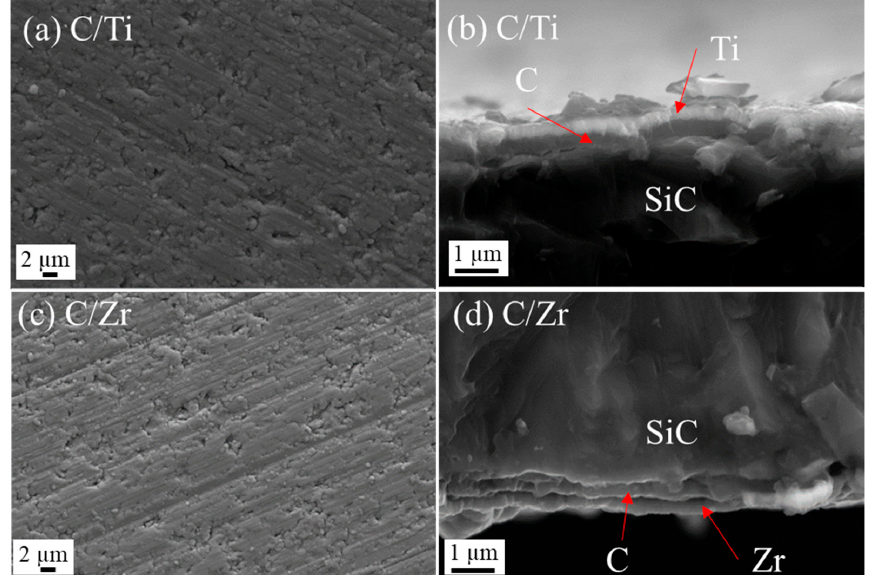
Figure 11. SEM images of surface and cross-section of sputtered coating with SE2 mode before heat treatment. ( a , b ) are the surface and cross-sectional image of sputtered C/Ti coating, respectively; ( c , d ) are the surface and cross-sectional image of sputtered C/Zr coating, respectively.